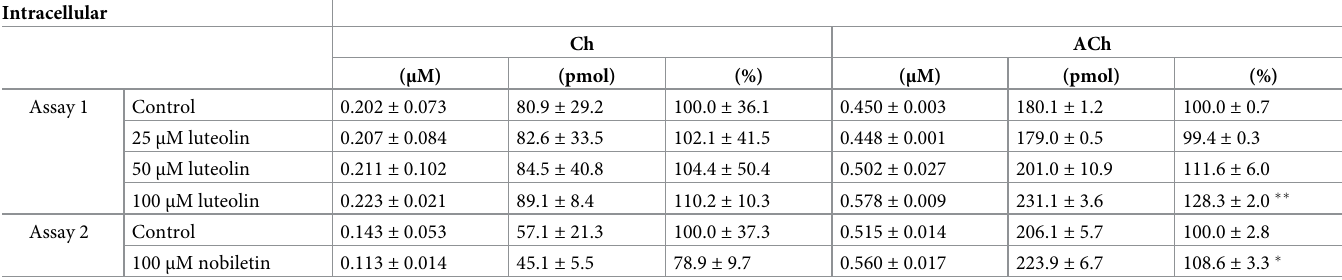
Table 3. Changes in the choline and acetylcholine levels in LA-N-2 cells after treatment with luteolin and nobiletin, which have been reported to have ChAT- increasing activity.